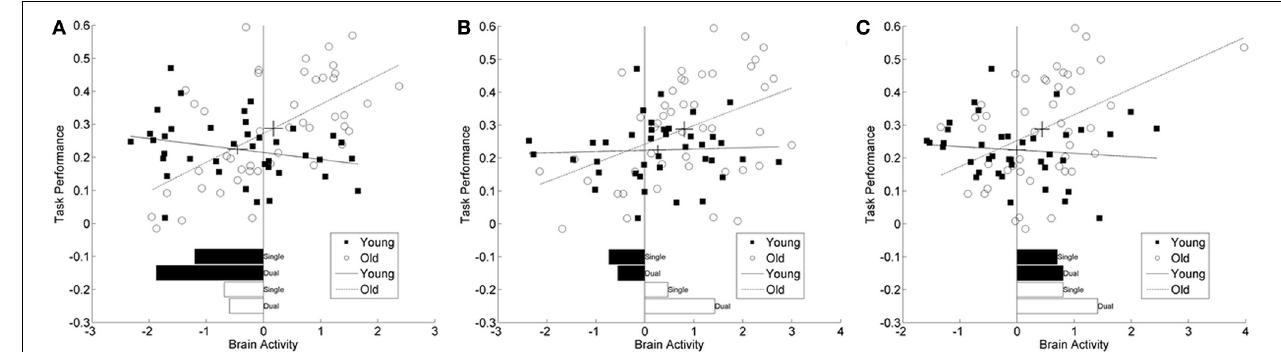
FIGURE 4 | Scatter plots from three representative brain locations. (A) superior frontal gyrus (20, 32, 52), (B) middle frontal gyrus (22, 48, 34), (C) cerebellum ( − 5, − 54, − 26). Each panel plots brain activity vs. task performance within age group, greater numbers reflect greater switch costs or worse performance. The lines correspond to the regression fit lines within each group and the cross-hairs on these lines are located at the mean values for brain activity and task performance. The length of the cross hairs corresponds to the standard errors of the means. Young adults are